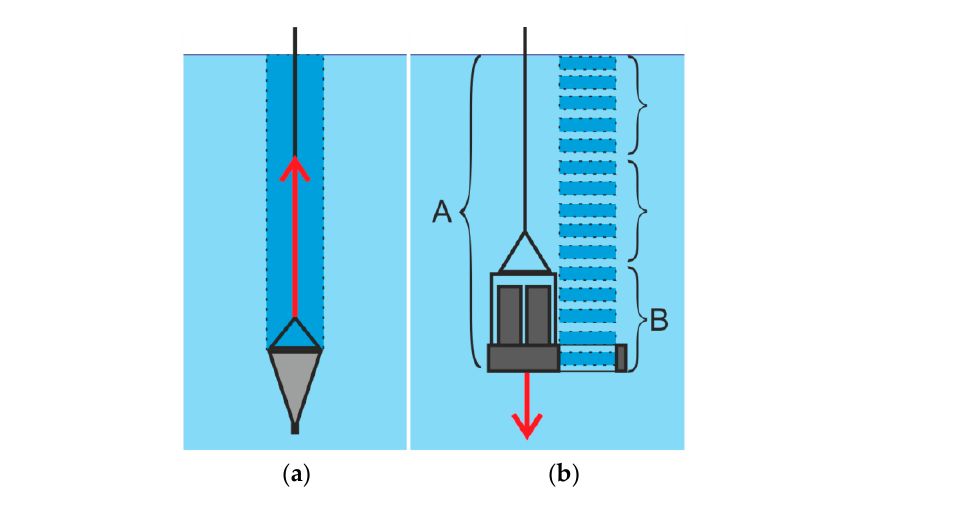
Figure 6. Sampling of particle data. The arrow shows the direction of movement to form a general sampling ( a ) Using a net, ( b ) Using the miniDHC. (A — sampled population; B — sampling from the sampled population to form one count). Table 4. Marine data for comparison of plankton measurements with average at the same maximum depth 7 m. Traditional Classification of Plankton Sample Using a Net Plankton Classification Using the